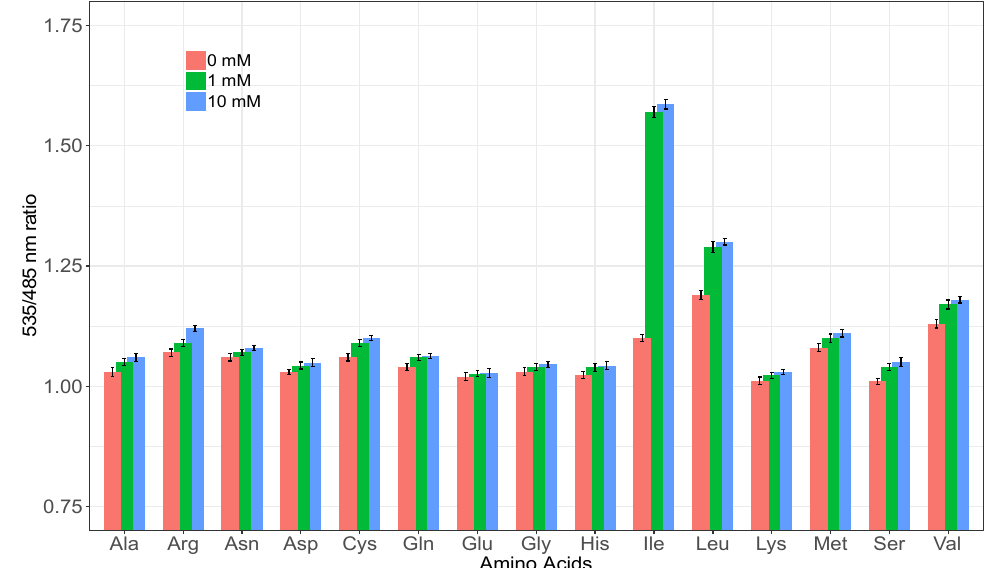
Figure 3. Specificity analysis of the GEII nanosensor. FRET ratio of the GEII sensor in absence and presence of 1 and 10 mM of different amino acids. All values are the mean of three independent experiments. Error bars indicate standard deviation. Excitation filter/slits (430/20 nm) and emission filters/slits for ECFP (485/20 nm) and Venus (535/25 nm) were used.